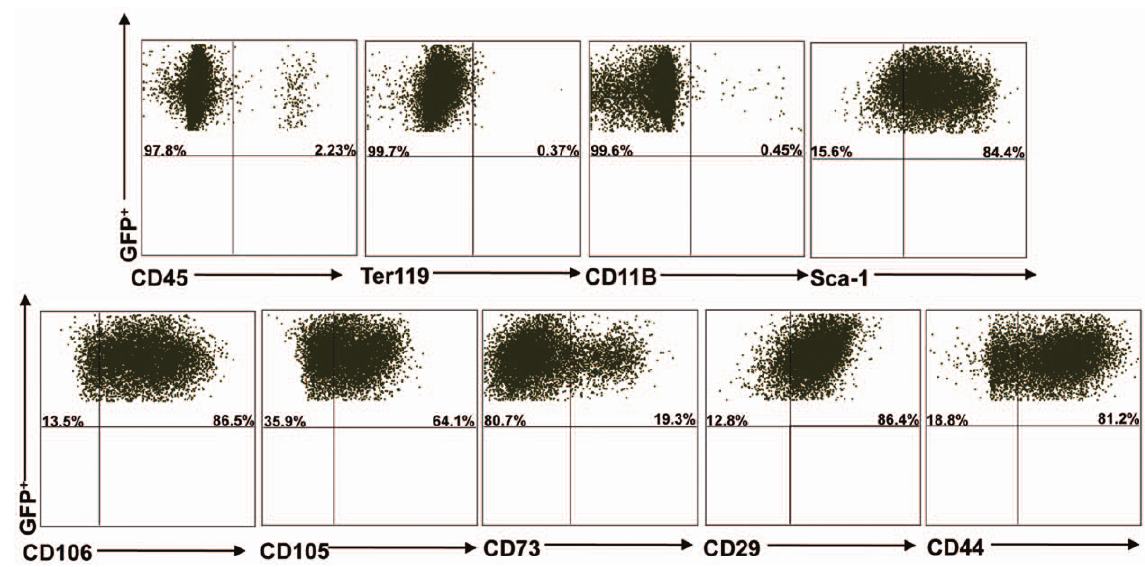
Figure 6. Flow cytometry analysis of CD45 2 /Ter119 2 cells. After 3 passages, CD45 2 /Ter119 2 cells were stained with the following surface markers: CD45, Ter119, CD11B, Sca-1, CD106, CD105, CD73, CD29 and CD44. Data are representative of at least three separate experiments. This experiment shows 97.8% CD45 2 , 99.7% TER119 2 , 99.6% CD11b 2 and 84.4% Sca1 + , 86.5% CD106 + , 64.1% CD105 + , 19.3% CD73 + , 86.4% CD29 + , 81.2% CD44 + cells.